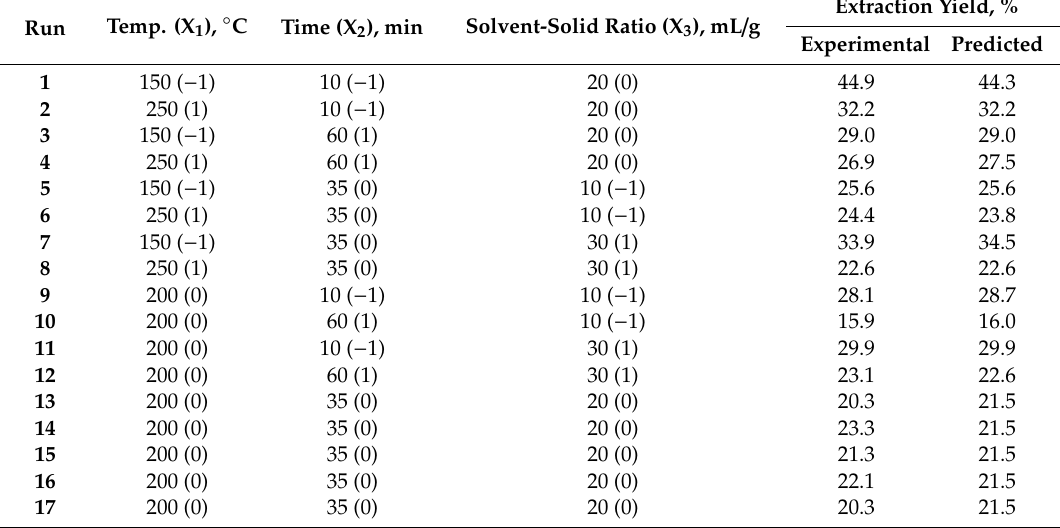
Table 1. Proposed experiments by the Box–Behnken method and the predicted and experimental values of extraction yield obtained by subcritical water extraction of chestnut bark.